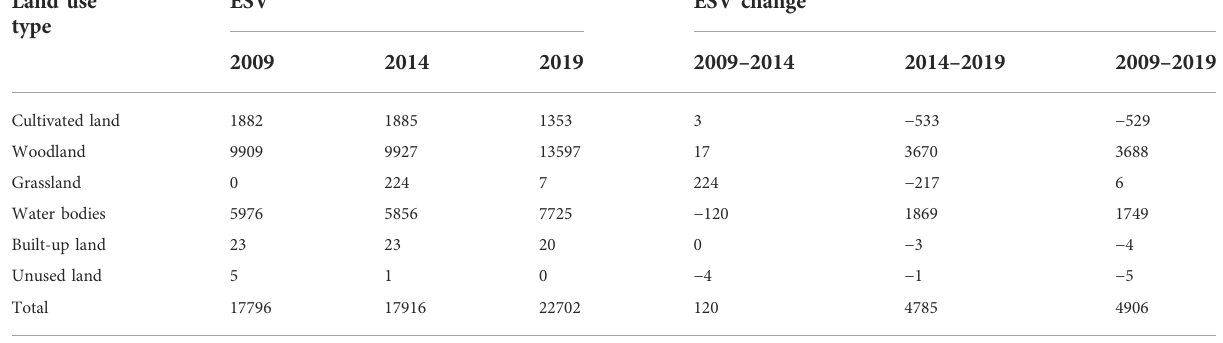
TABLE 2 Changes of ESV in Jiangjin during 2009 – 2019 (million RMB/hm 2 /year).